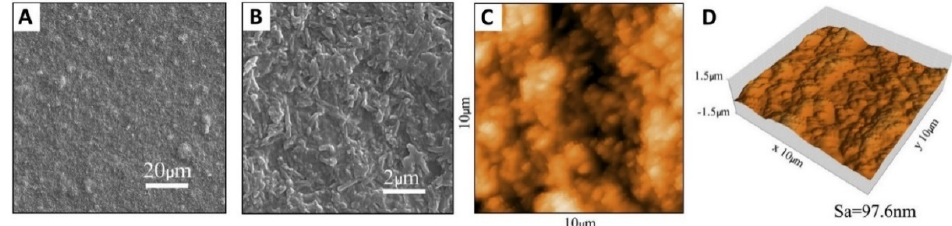
Figure 6. The examples of combination of ( A , B ) SEM and ( C , D ) atomic force microscopy (AFM) data to investigate halloysite nanotubes. Reproduced with permission from Ref. [124]. Copyright 2018 Elsevier.